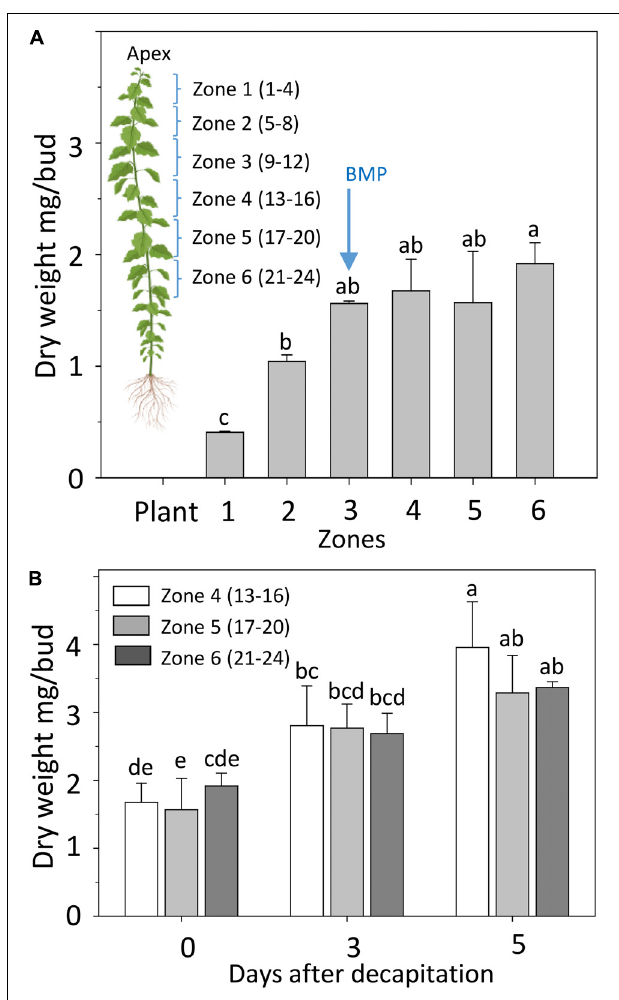
FIGURE 3 | Development of AXBs. (A) AXBs in different zones along the stem in intact plants. The numbers in parenthesis of zones indicate the position of AXBs, counted from the top. (B) AXB enlargement after decapitation in the remaining zones 4–6. Values represent the means of three biological replicates ± S.E. ( n = six plants). One-way ANOVA. Different letters indicate statistical differences between samples (Fischer’s LSD post hoc analysis; P -value at least <